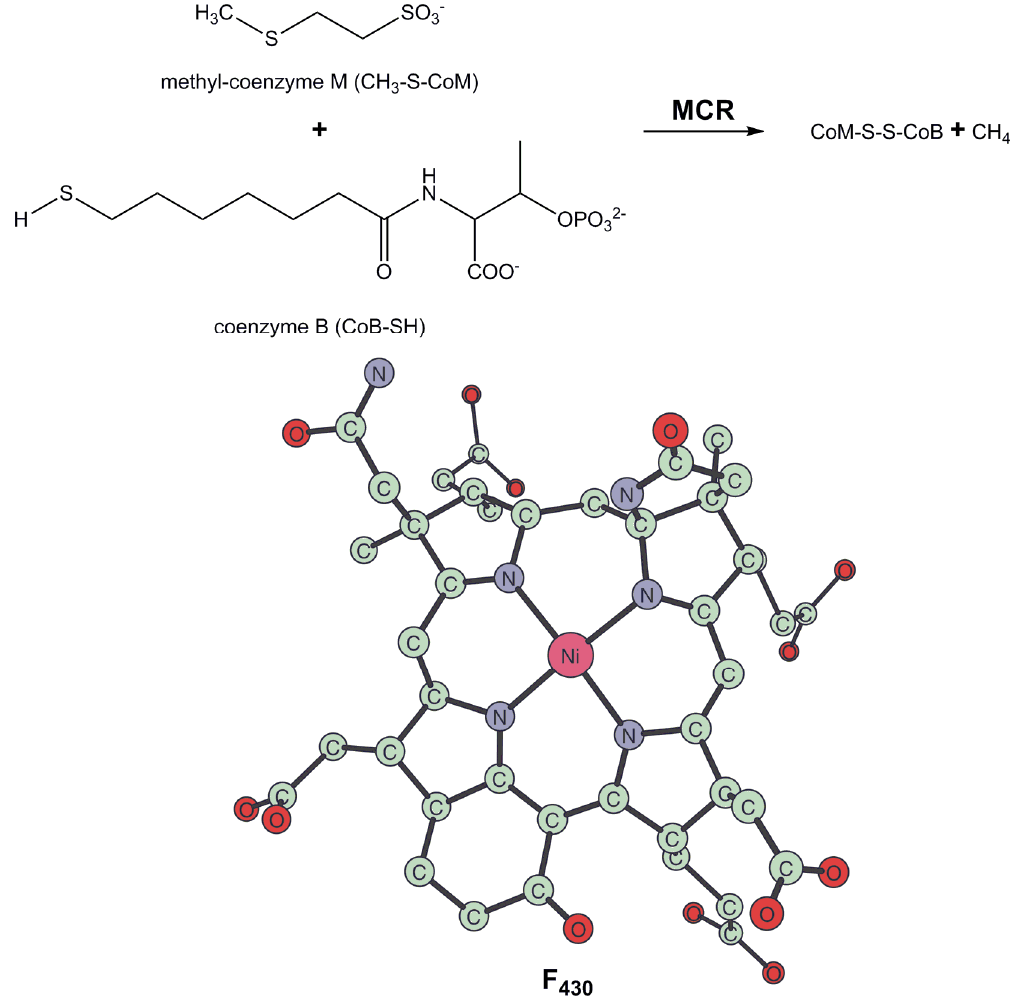
Figure 4. The reaction catalyzed by methyl-coenzyme M reductase (MCR) using a F 430 cofactor.